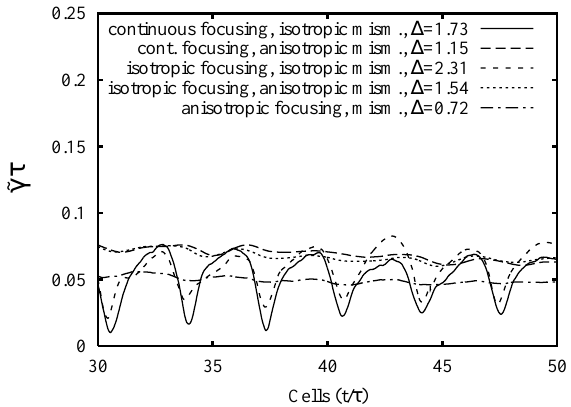
FIG. 8. Normalized friction coefficients ˜ gt for 10 000 simu- lation particles versus the number of cells obtained by 3D simu- lations of different focusing systems and matching conditions at s 0 (cid:1) 60 ± , s (cid:1) 15 ± per cell, for a normalized correlation time dt (cid:1) t (cid:1) 0.4